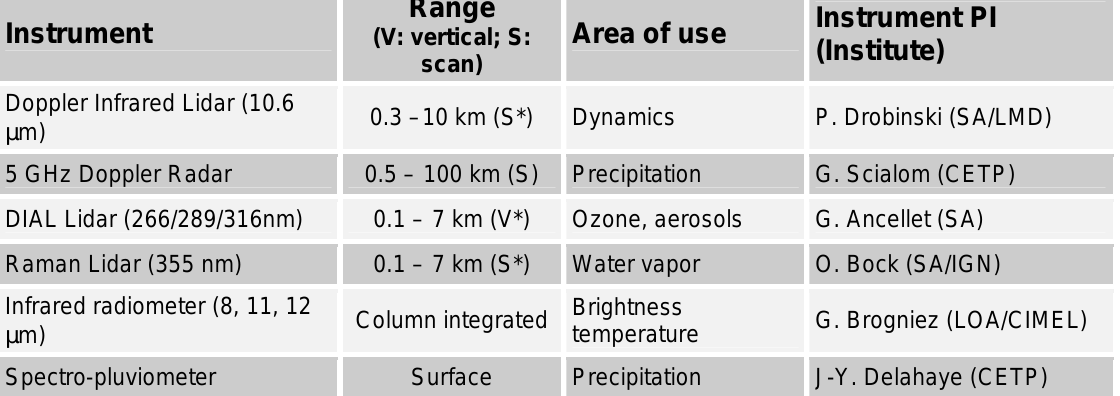
Table 3: List of instruments developed at IPSL and collaborating institute that operate at SIRTA in the context of specific field campaigns. Instrument